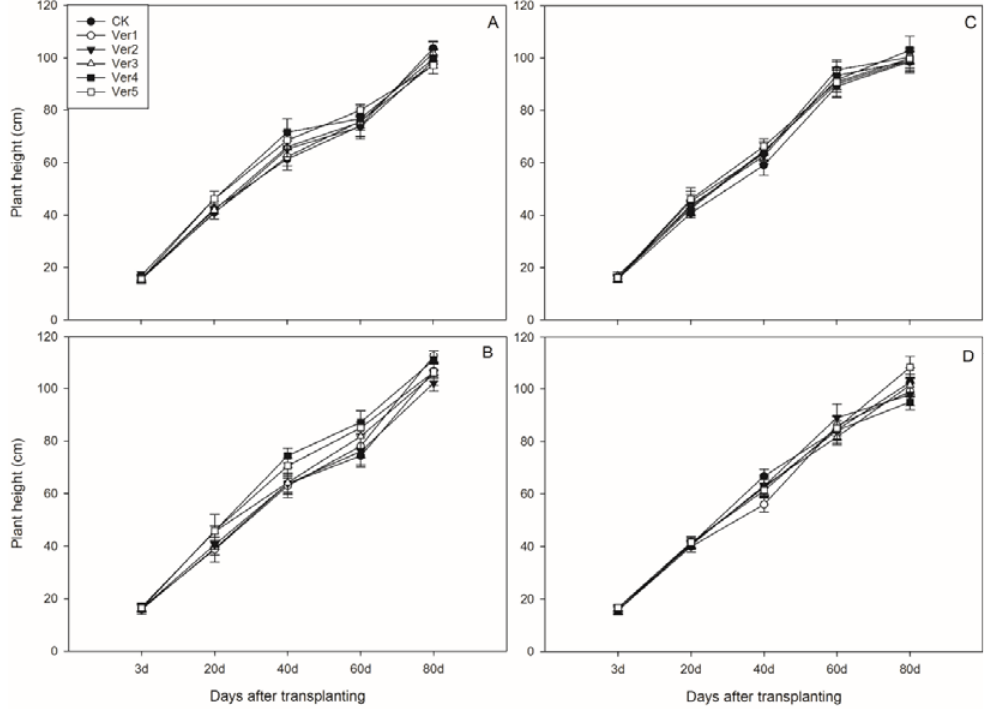
Figure 2. Effects of different vermicompost rates on plant height of fragrant rice cultivars. ( A ) Meixiangzhan-2 in early lug; ( B ) Meixiangzhan-2 in late lug; ( C ) Xiangyaxiangzhan in early lug; ( D ) Xiangyaxiangzhan in late